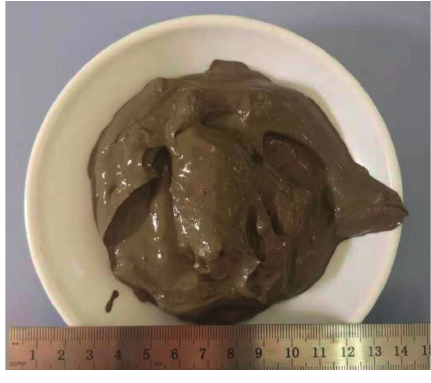
Figure 1: The testing slurry. Table 1: The physical and mechanical properties of the building slurry.